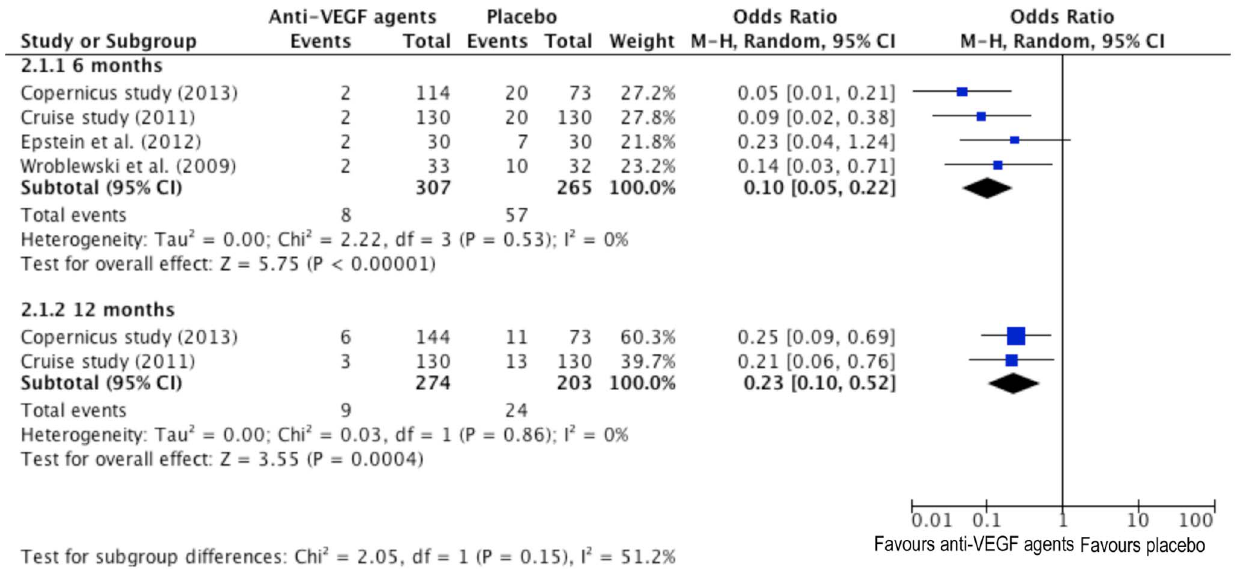
Figure 3. Forrest plots for the proportion of patients with a loss from baseline in best-corrected visual acuity (BCVA) of greater than or equal to 15 letters on Early Treatment in Diabetic Retinopathy Study (ETDRS) Chart at six and twelve months between anti- VEGF and placebo group.